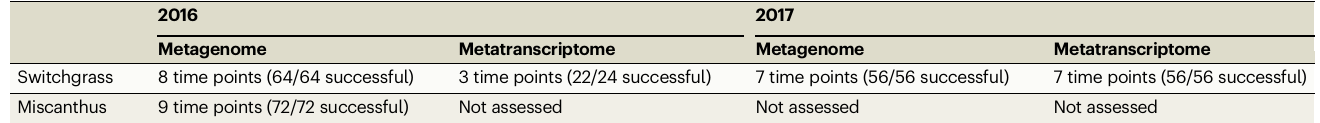
Ecological Research site focused on agroecosystems located in southwest Michi- gan. B Four replicate randomized cropping system blocks from the Biofuel Crop- ping System Experiment (BCSE) were sampled at each time point for switchgrass (green) and/or miscanthus (blue). Within each plot, a fertilized main plot and unfertilized subplot were sampled. C Symbol fi ll shows which sequencing was